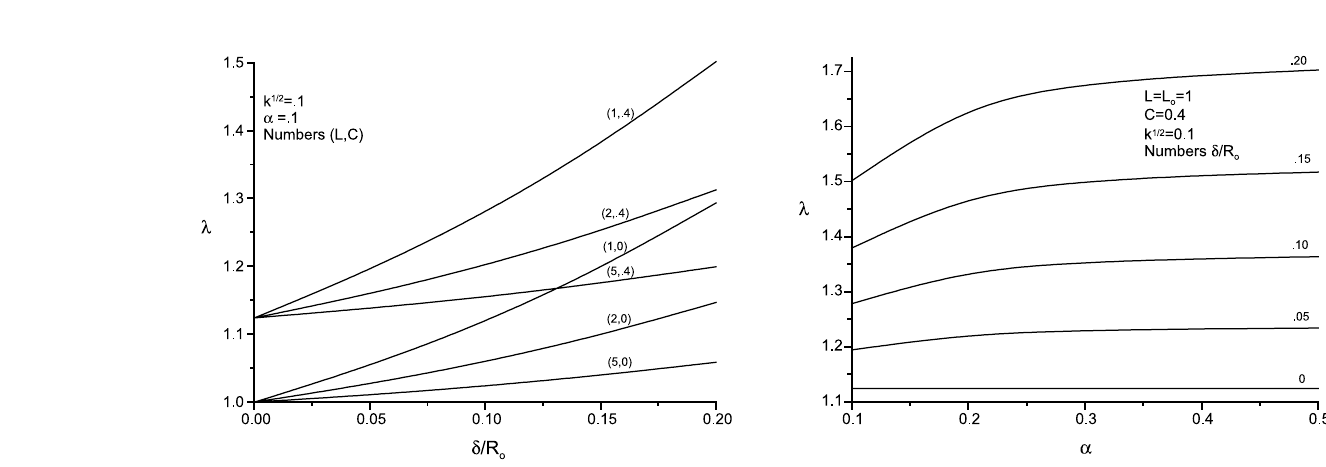
Fig. 8. Impedance, λ versus slip parameter, α for different stenosis height, δ/ R o .